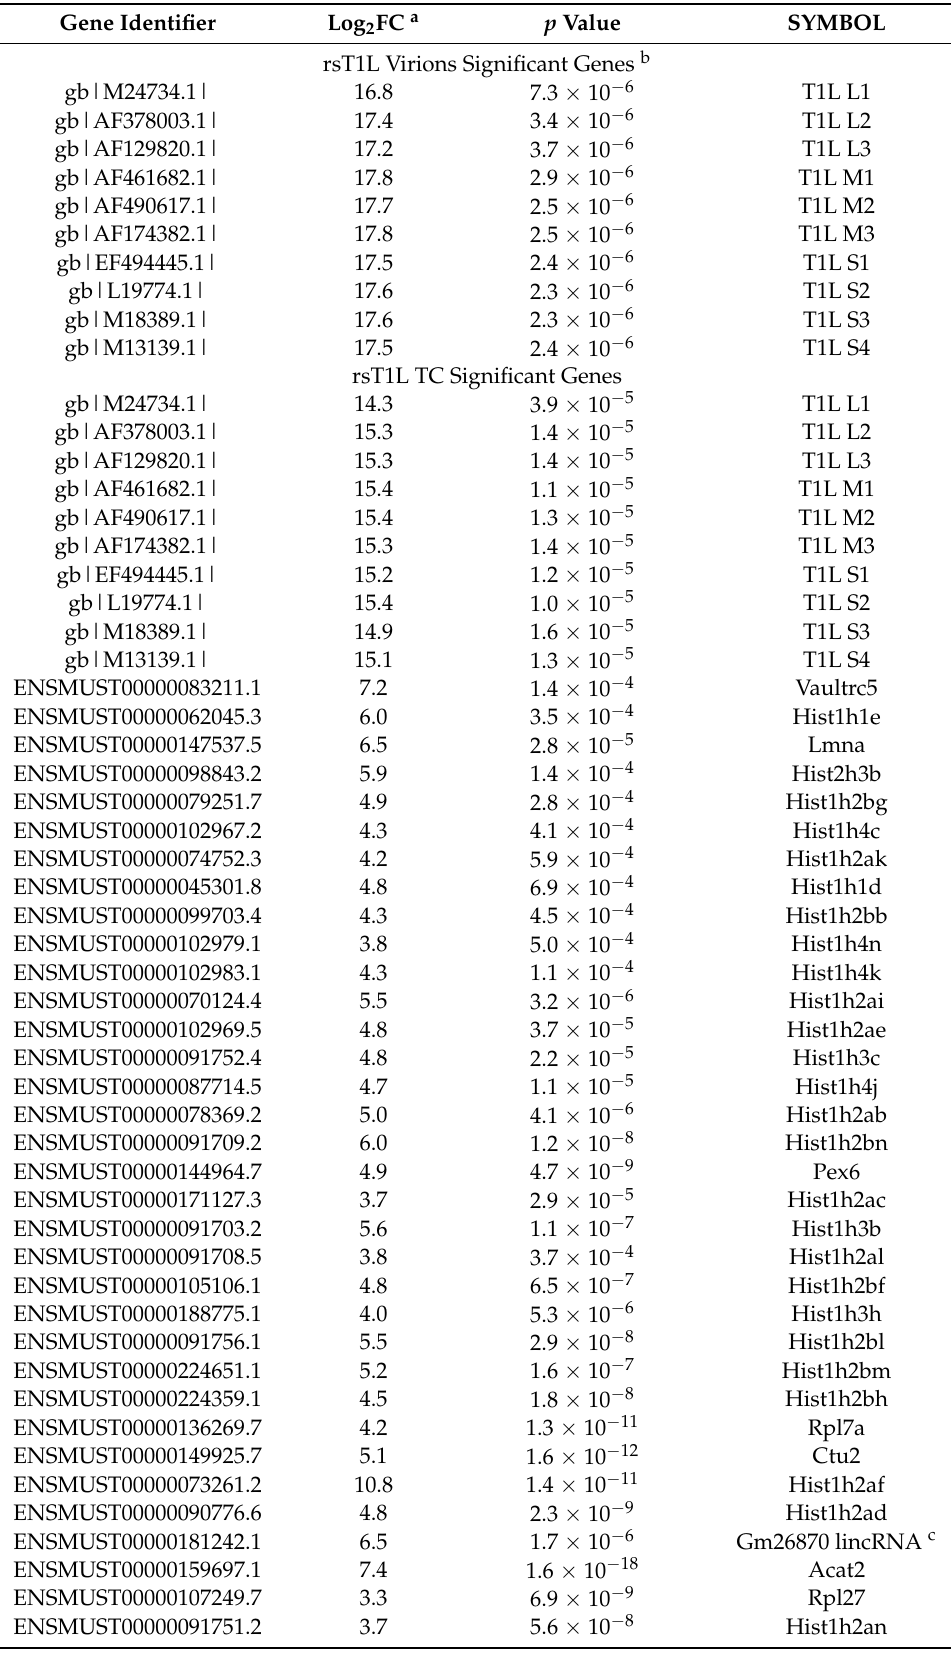
Table 3. Viral and host transcripts packaged by rsT1L and rsT3D I T1L1